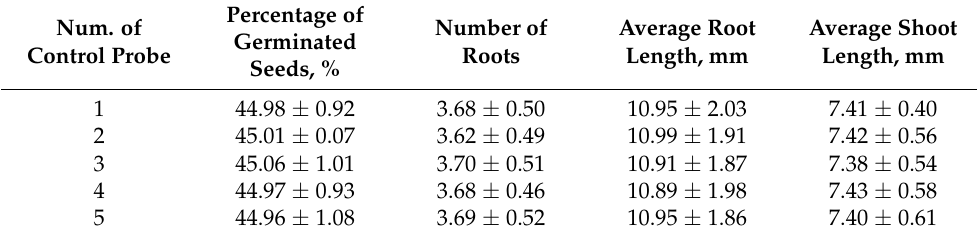
Table 2. Morphological and functional parameters of seed germination in water. Num. of